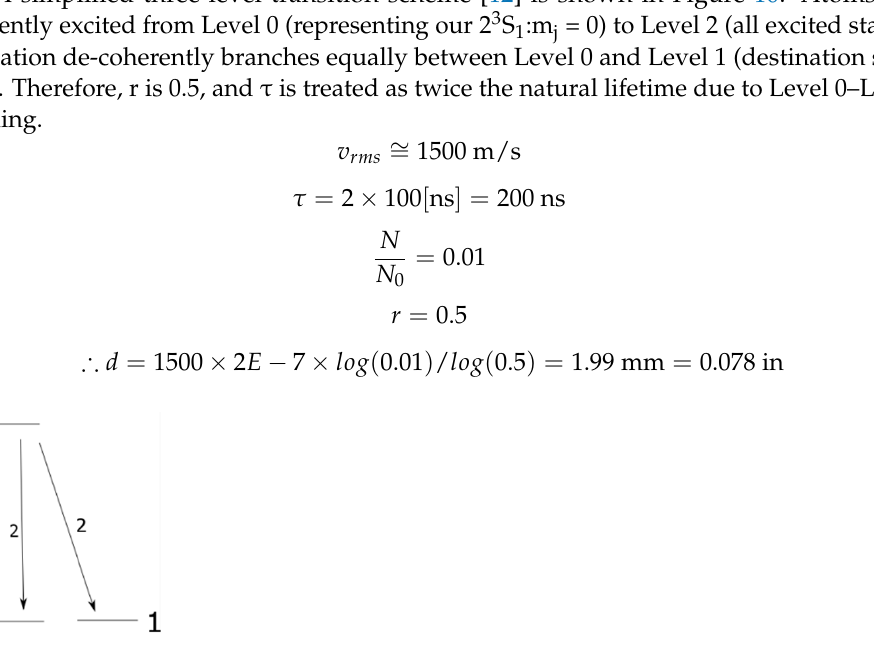
Figure 10. Simplified three-level schematic (normalized branching ratios labeled on arcs).